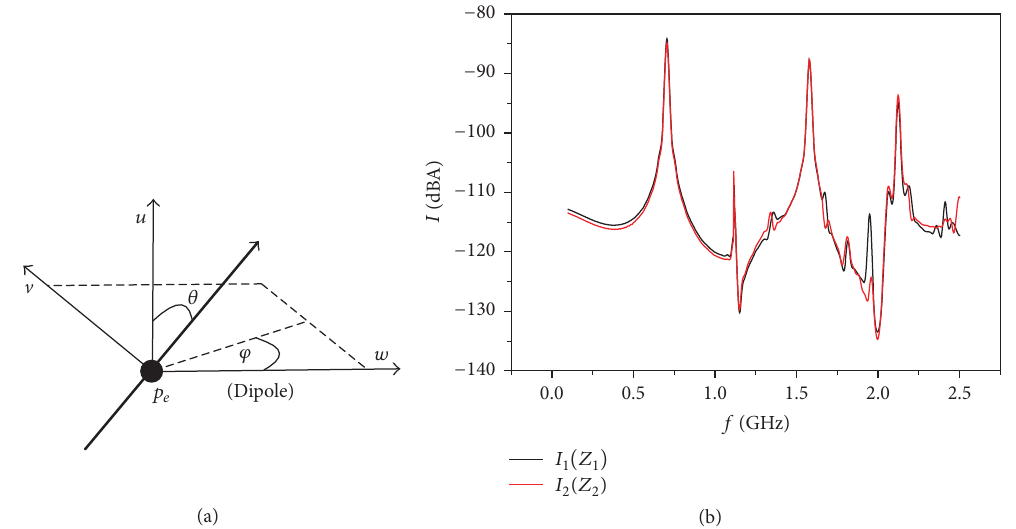
Figure 11: (a) An arbitrary directed electric dipole of the elevation angle 𝜃 = 45 ∘ and the azimuth angle 𝜑 = 30 ∘ . (b) The electric current induced at termination loads 𝑍 1 and 𝑍 2 for the arbitrary directed electric dipole.